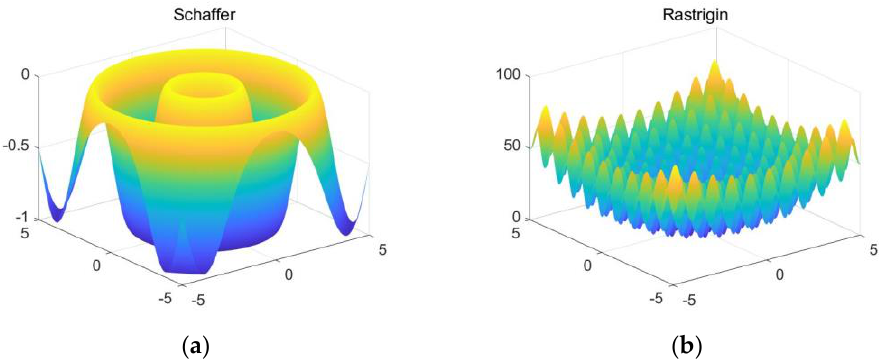
Figure 2. Images of the two test functions: ( a ) Schaffer function; ( b ) Rastrigin function.